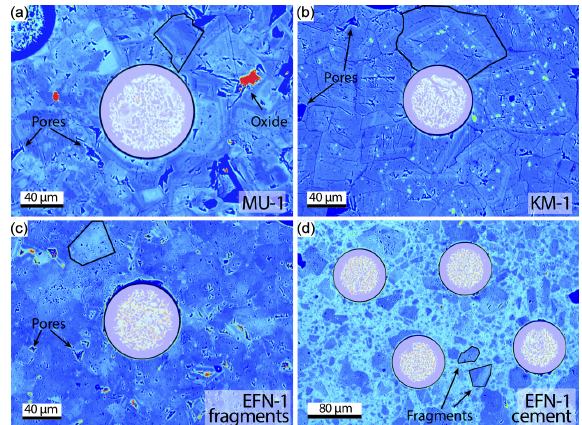
Figure 6. Panchromatic BSE images of samples MU-1 (a) and KM- 1 (b) as well as fragments and cement from sample EFN-1 ( c and d , respectively). BSE images are efficient in revealing the grain size of the sample, as well as porosity and additional intracrystalline phases. LA craters are marked by circles of 85µm diameter. Repre- sentative grain boundaries are marked by black